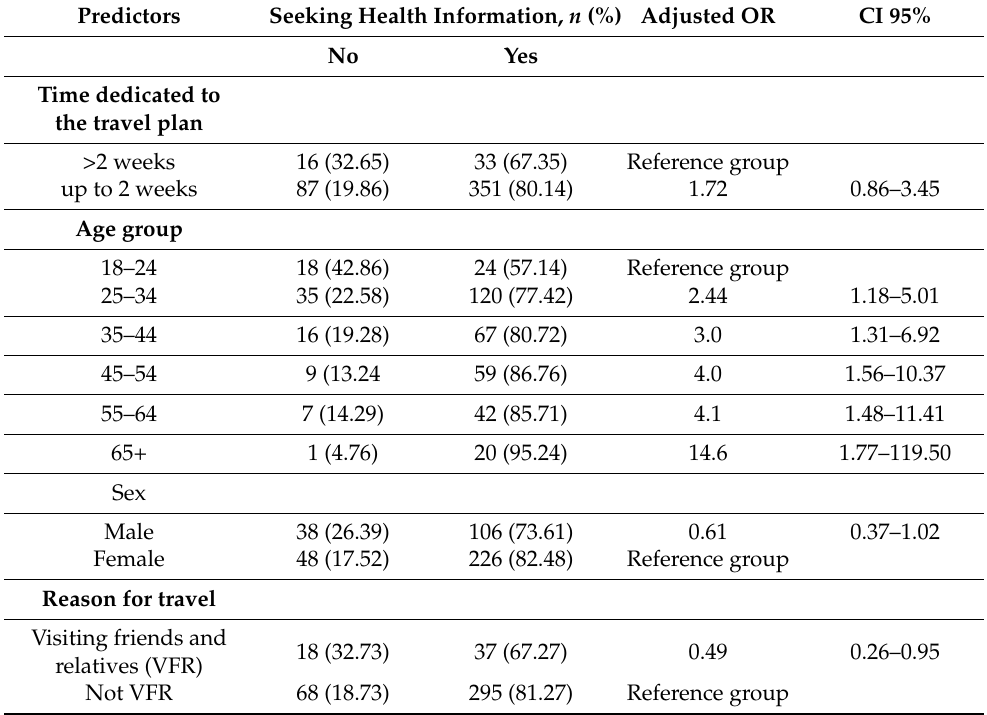
Table 5. Multivariate logistic regression analysis: predictors of seeking information before traveling.